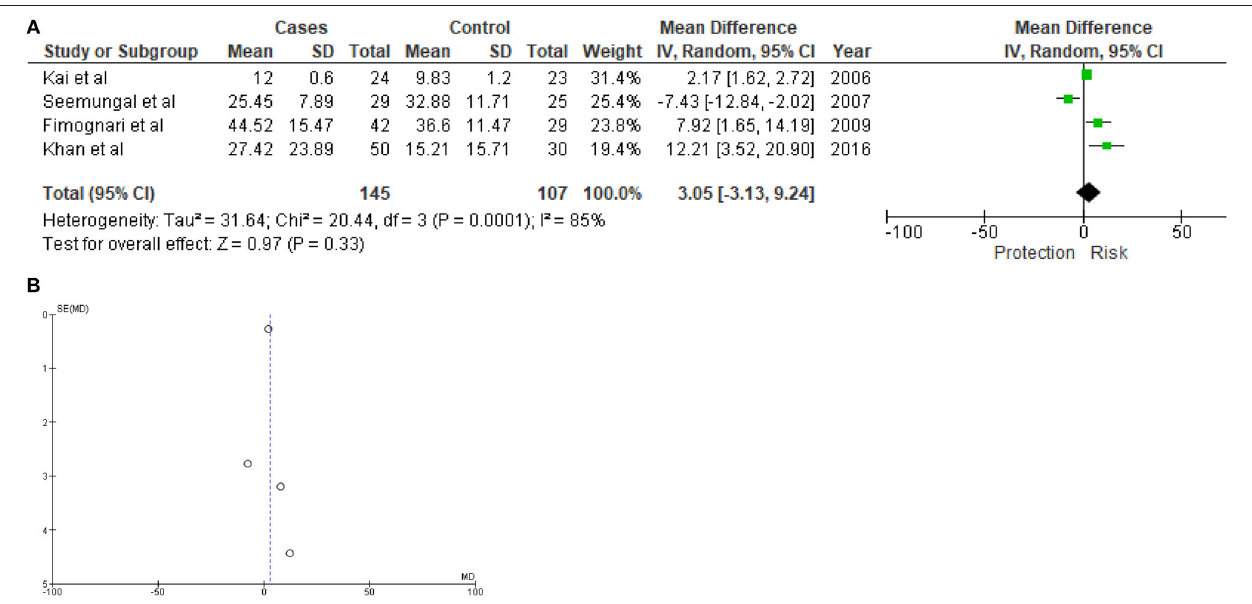
high degree of statistical as well as biological